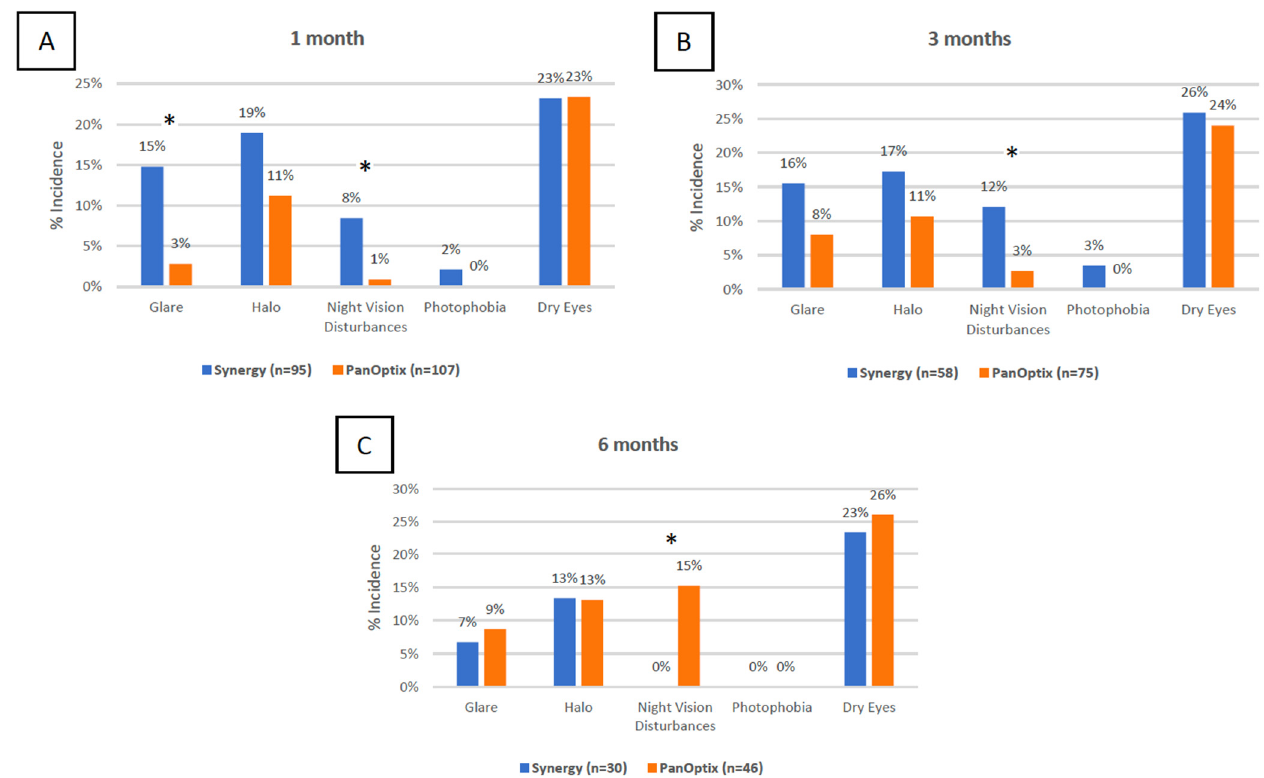
Figure 2. Distribution of secondary visual outcomes at the one-month: ( A ), three months ( B ), and six months ( C ) time intervals in the TECNIS Synergy and AcrySof IQ PanOptix groups. (* = statistically significant interval).